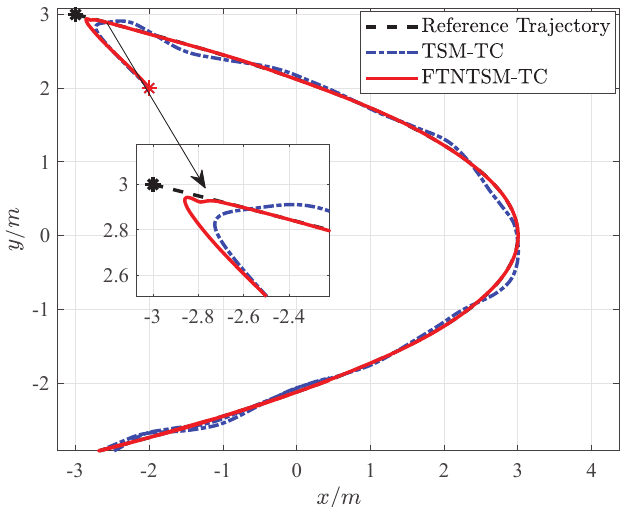
Figure 3. Tracking control of TSM-TC and FTNTSM-TC.